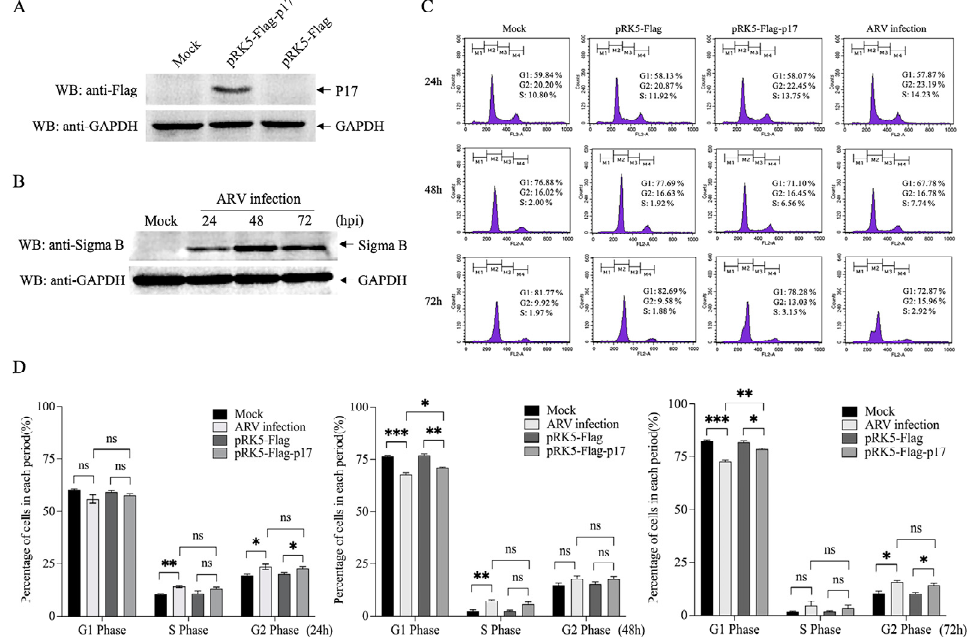
Figure 1. Examination of the effects of overexpressed Flag-p17 and ARV infection on Vero-E6 cell cycle. ( A ) Expression of p17 protein in Vero-E6 cells. Vero-E6 cells were seeded on 12-well plates and cultured overnight. Cells were then transfected with pRK5-Flag or pRK5-Flag-p17 plasmid. Twenty-four hours after transfection, cell lysates were prepared and examined with anti-Flag and anti-GAPDH antibodies. ( B ) Examination of ARV infection. Vero-E6 cells were infected with ARV at an MOI of 1. Cell lysates were extracted at different time points (24 h, 48 h and 72 h) post infection and examined by Western Blot using anti-Sigma B and anti-GAPDH antibodies. ( C ) p17 overexpression or ARV infection induced cell-cycle arrest at G2/M phase. Vero-E6 cells were treated with pRK5-Flag-p17 transfection or ARV infection (MOI = 1). At different time points (24 h, 48 h and 72 h), cells remaining in different phases were analyzed by flow cytometry. ( D ) The percentage of all period cells in ( C ) was quantified. * stands for p < 0.05, ** stands for p < 0.01 and *** stands for p < 0.001.